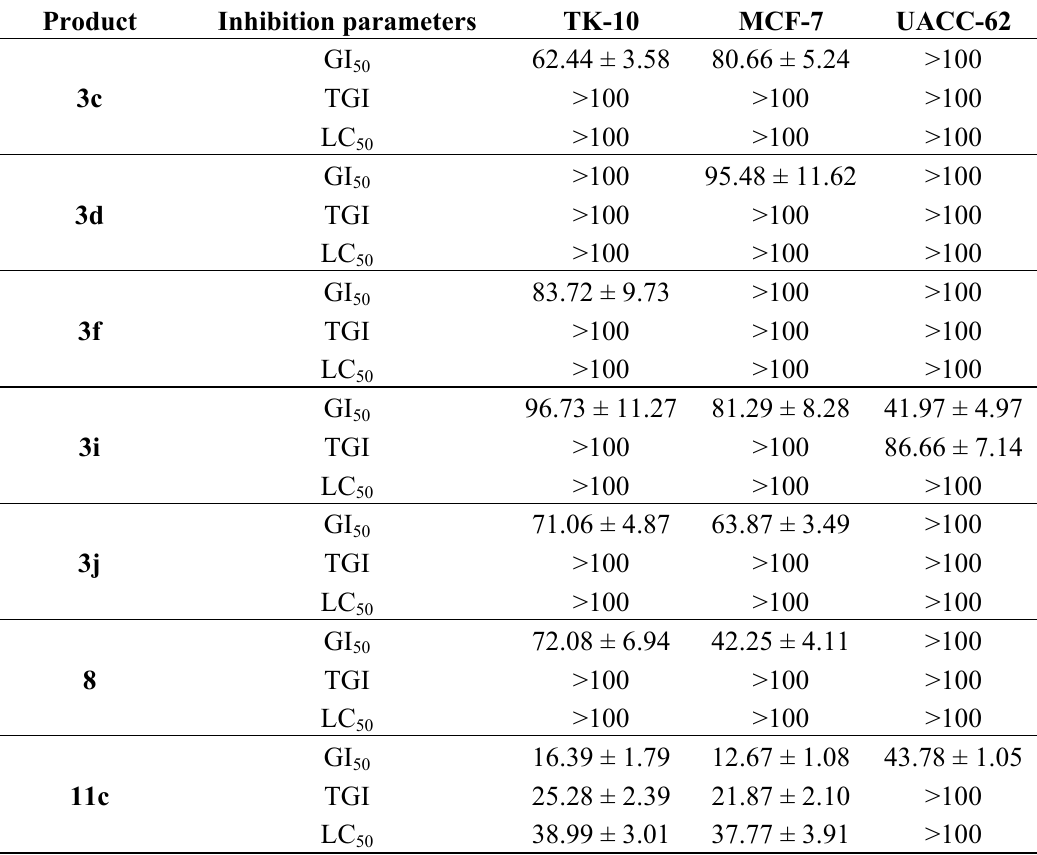
Table 2. Concentration (µM/mL) required to inhibit cell growth by 50% (GI total growth inhibition (TGI) and to cause 50% net cell killing (LC